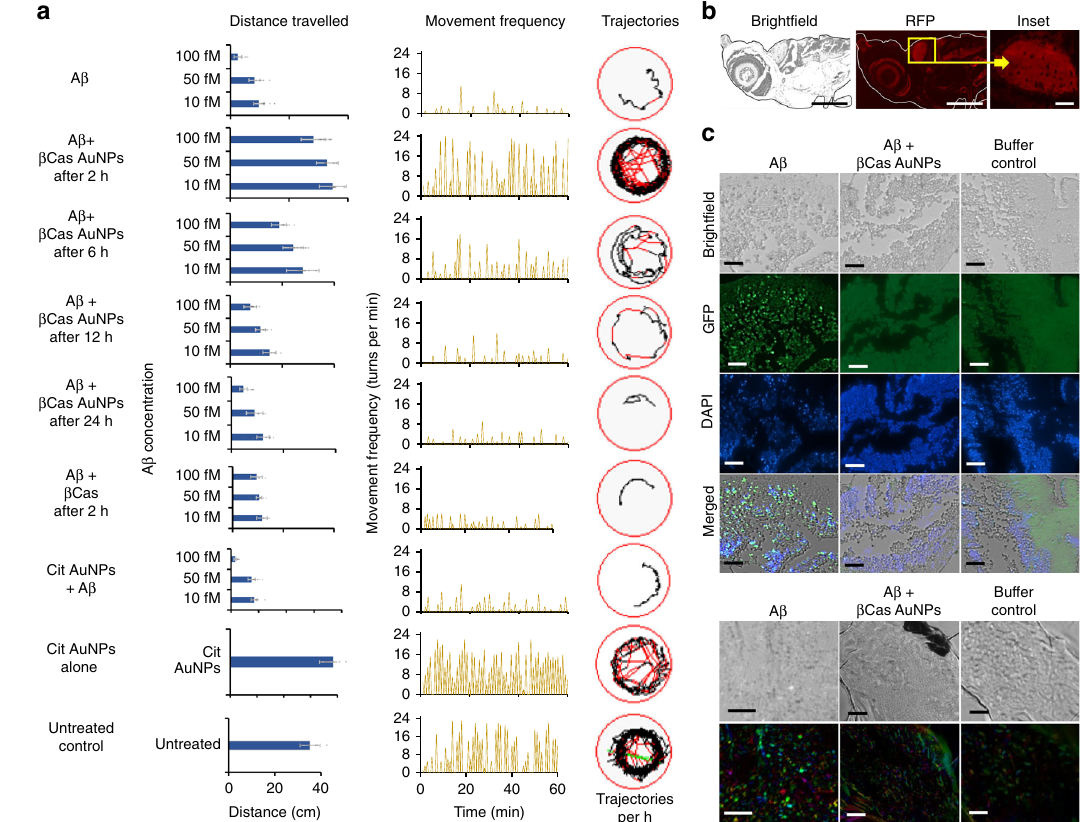
Fig. 5 Mitigation of A β toxicity in zebra fi sh larvae with β Cas AuNPs. a A β peptide was injected into the cerebroventricular space at 10, 50, and 100 fM concentrations ( n = 20, mean ± SD). Zebra fi sh larvae were monitored on an automated behavior monitoring system at fi fth day post A β treatment and parameters of total distance traveled, movement frequency and trajectory path were observed for 1 h. Signi fi cant ( p < 0.005) difference in the behavior of the larvae was observed on the fi fth day post treatment. β Cas AuNPs injected, via the intracardiac route 2 and 6 h after the A β treatment, rescued the larvae from A β toxicity and from developing Alzheimer ’ s-like symptoms. Representative trajectories of the larvae are displayed in the far-right column. Treating the larvae with β Cas AuNPs, 12 and 24 h post A β treatment, failed to protect the larvae from developing A β toxicity. b Zebra fi sh larvae, treated with β Cas AuNPs 2 h after A β treatment were fi xed, sliced and stained with Congo red to image any A β fi brils that could have formed. Tissue slices of the brain section did not present any red fl uorescence, indicating no A β fi bril formation in β Cas AuNPs treated larvae (scale bars: 200 µ M; inset scale bar: 20 µ M). Furthermore, immunohistochemistry (IHC) ( c ) and polarized light microscopy (apple green birefringence of amyloid) ( d ) revealed deposition of aggregated A β in the larval brain while no A β deposition was observed in β Cas AuNPs or buffer treated larvae (Scale bars: IHC, 30 µ M; polarized light microscopy, 50 µ M). Error bars represent the standard deviation. Source data are provided as a Source Data fi